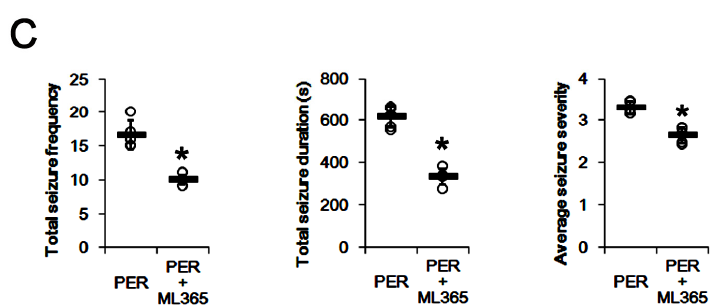
Figure 7. The effect of ML365 co-treatment with perampanel (PER) on spontaneous seizure activities in non-responders to PER. ML365 co-treatment improves the efficacy of PER in non-responders ( A ) Representative electroencephalograms (EEG) in each group at 4 days after treatment. ( B ) Quantitative analyses of the chronological effects of PER on seizure frequency, seizure duration and seizure severity (seizure score) over the 7-day period. Error bars indicate SD (* p < 0.05 vs. PER-treated animals). ( C ) Quantitative analyses of total seizure frequency, total seizure duration and average behavioral seizure score (seizure severity) in the 7-day period. Open circles indicate each individual value. Horizontal bars indicate the mean value. Error bars indicate SD (* p < 0.05 vs. PER-treated animals).